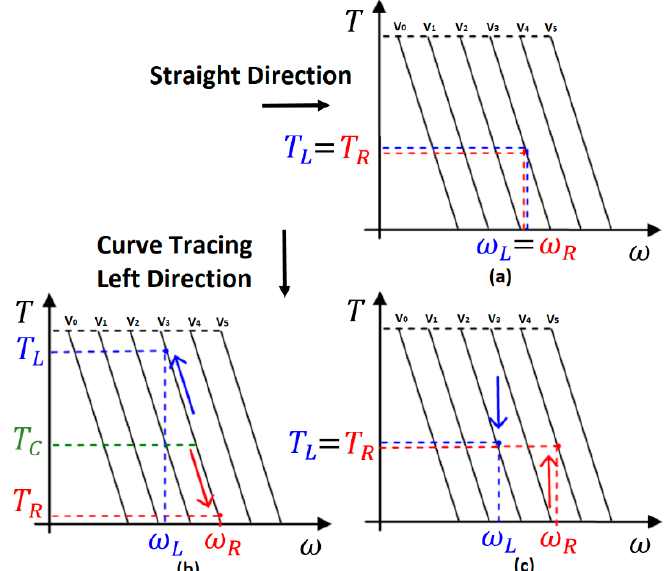
Figure 3. Operation performance of an ED with torque equalization of two parallel driving motors: ( a ) Parameters of the motors of the vehicle tracing a straight path; ( b ) Variation of the torque and angular speed of the two motors while the vehicle starts tracing a curve to the left; ( c ) control evolution generated by the ED to conduct the curve properly.